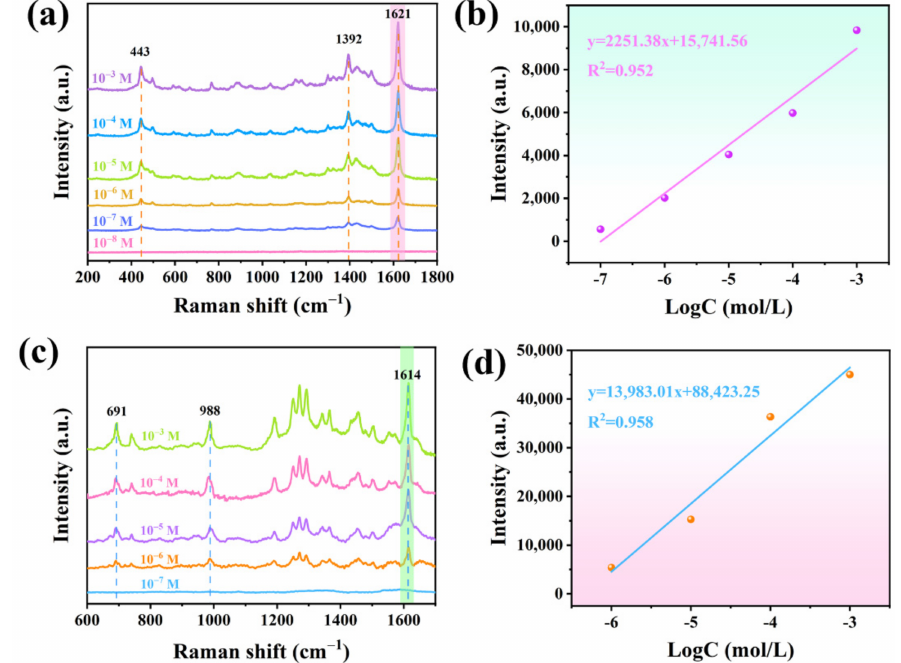
Figure 5. ( a ) SERS spectra of MB at various concentrations from 10 − 3 to 10 − 8 M and ( b ) the corre- sponding plot of SERS intensity and logarithmic concentration of MB at 1621 cm − 1 . ( c ) SERS spectra of BR at various concentrations from 10 − 3 to 10 − 7 M and ( d ) corresponding plot of logarithmic concentration and SERS intensity of BR at 1614 cm − 1